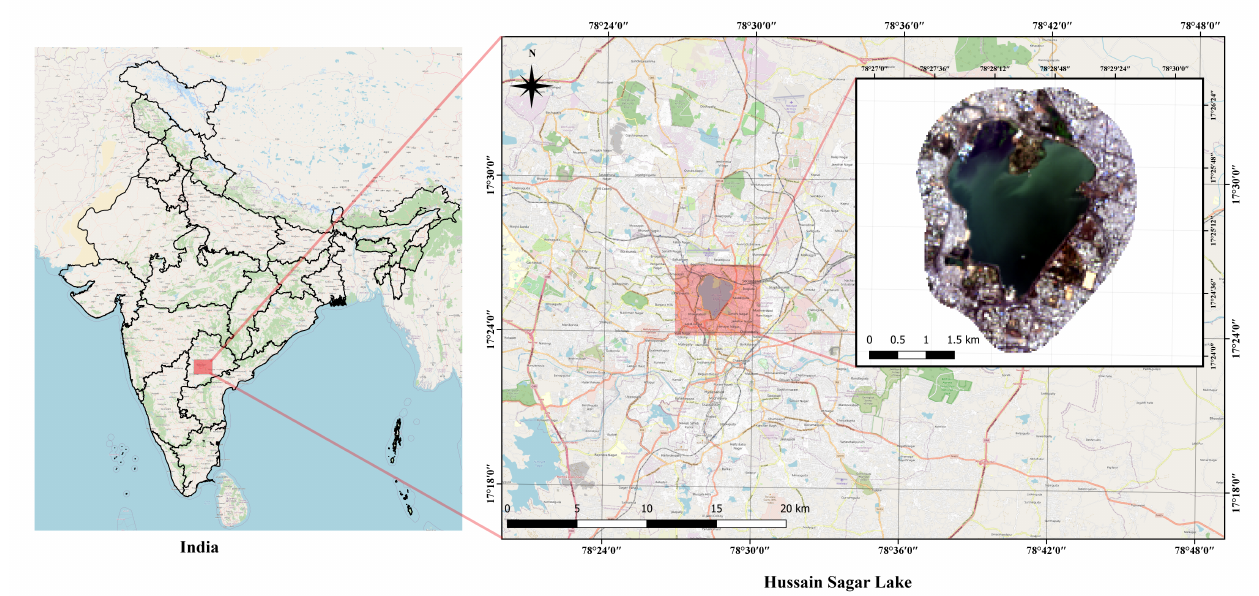
Figure 2. Location Map of Lake Hussain Sagar,